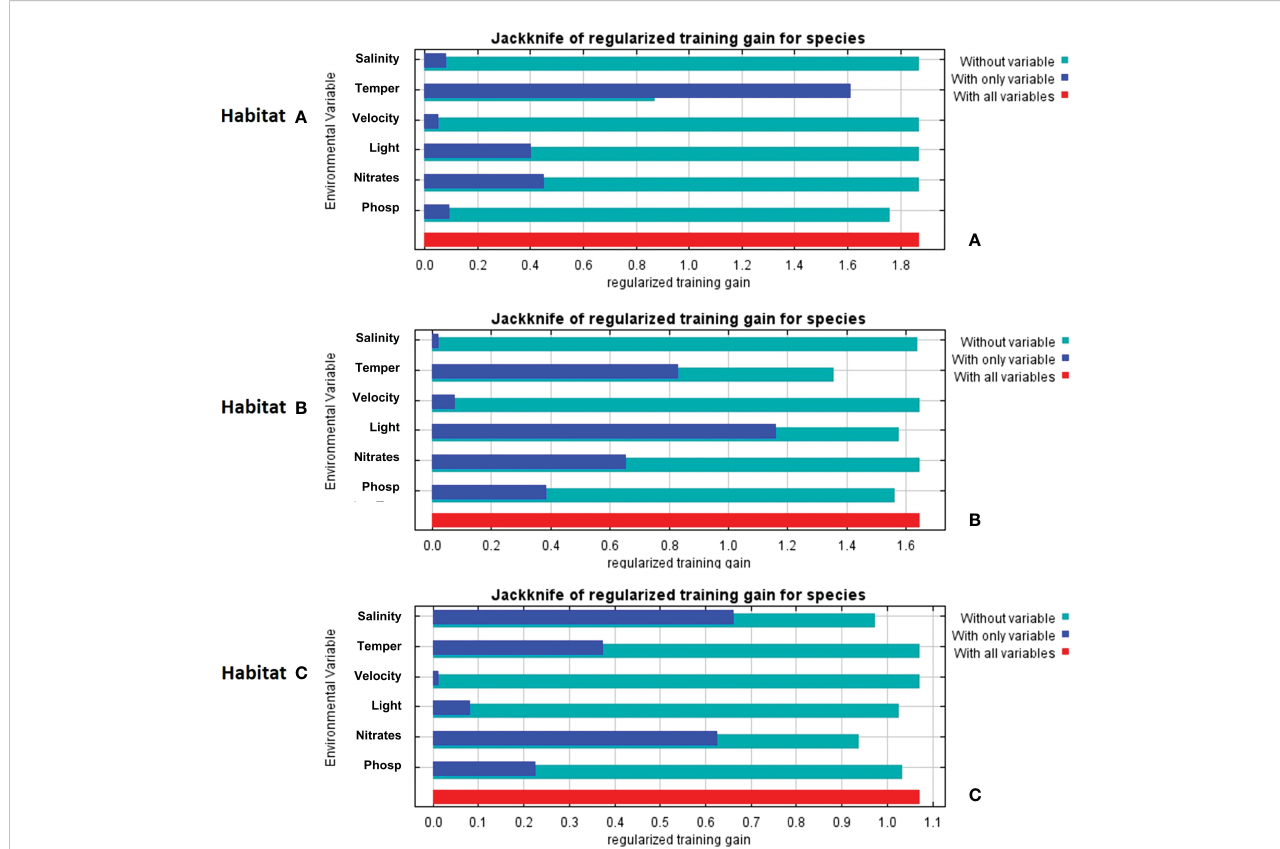
FIGURE 6 Jackknife analyses results derived from MaxEnt reporting the contribution and potential effects of variables on the model fi t (referred in the system as “ gain ” ): (A) Jackknife analysis of habitat A; (B) Jackknife analysis of habitat B; (C) Jackknife analysis of habitat